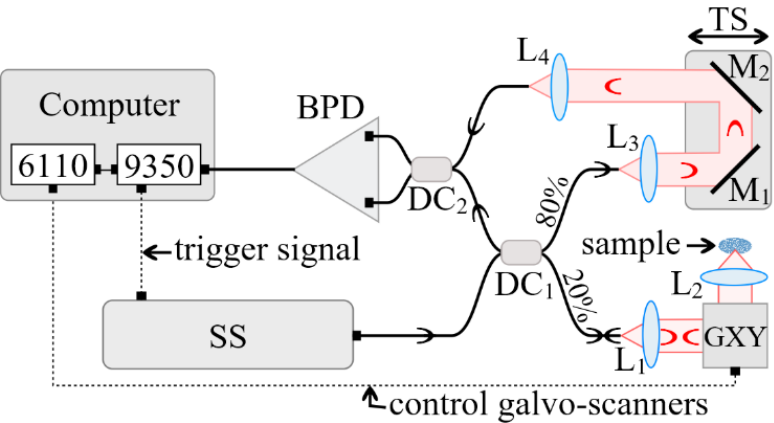
Figure 2. In-house developed Master Slave (MS)/swept source (SS)-optical coherence tomography (OCT) system. Components: SS—swept source; DC 1,2 single mode directional couplers (20/80 and 50/50, respectively); GXY dual axis XY galvanometer scanner; L 1–4 , achromatic lenses; BPD—balanced photo-detector; TS—translation stage.